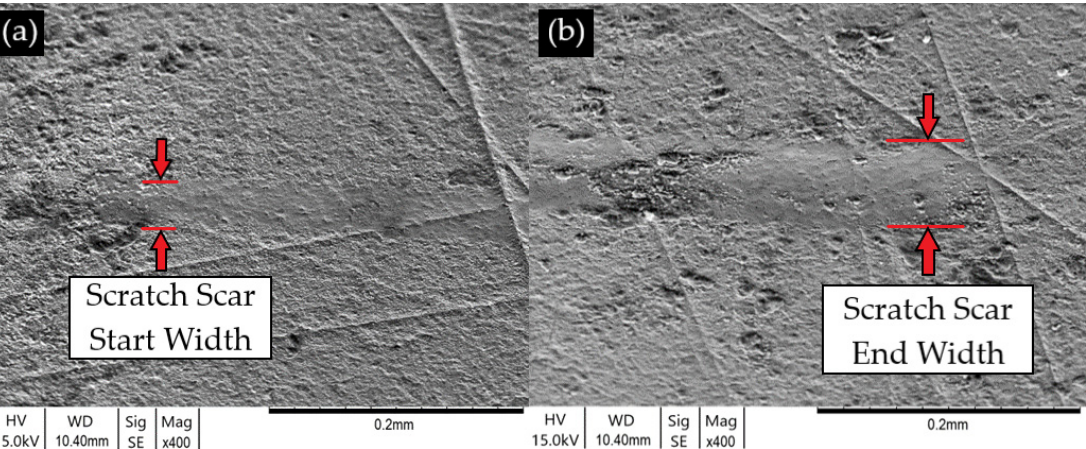
Figure 22. ( a ) Coating B scratch position 1 and ( b ) Coating B scratch position 3 at ×400 magnification.